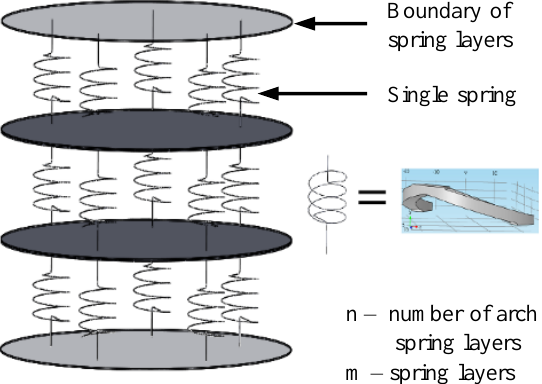
Figure 4. Cylindrical arch spring structure was analytically modelled for further modifications.